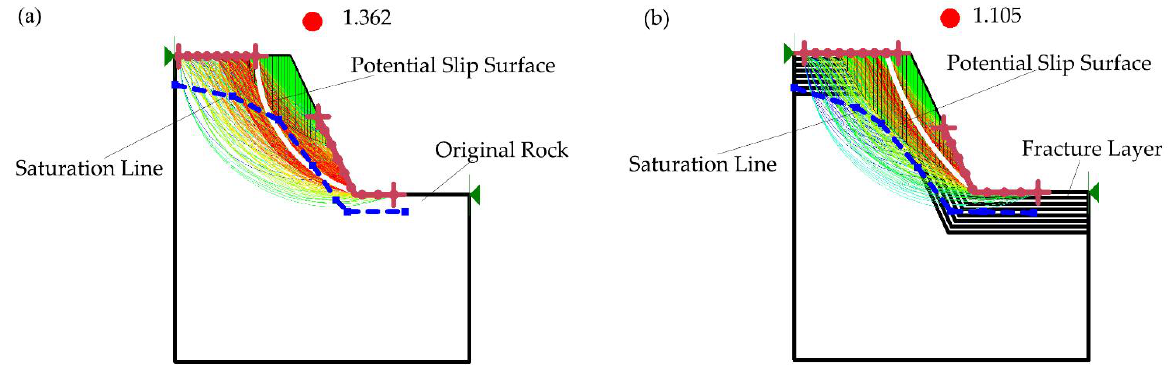
Figure 3. Simulation analysis of shallow damage: ( a ) Stability analysis of original rock slope; ( b ) Stability analysis of failed rock mass slope.